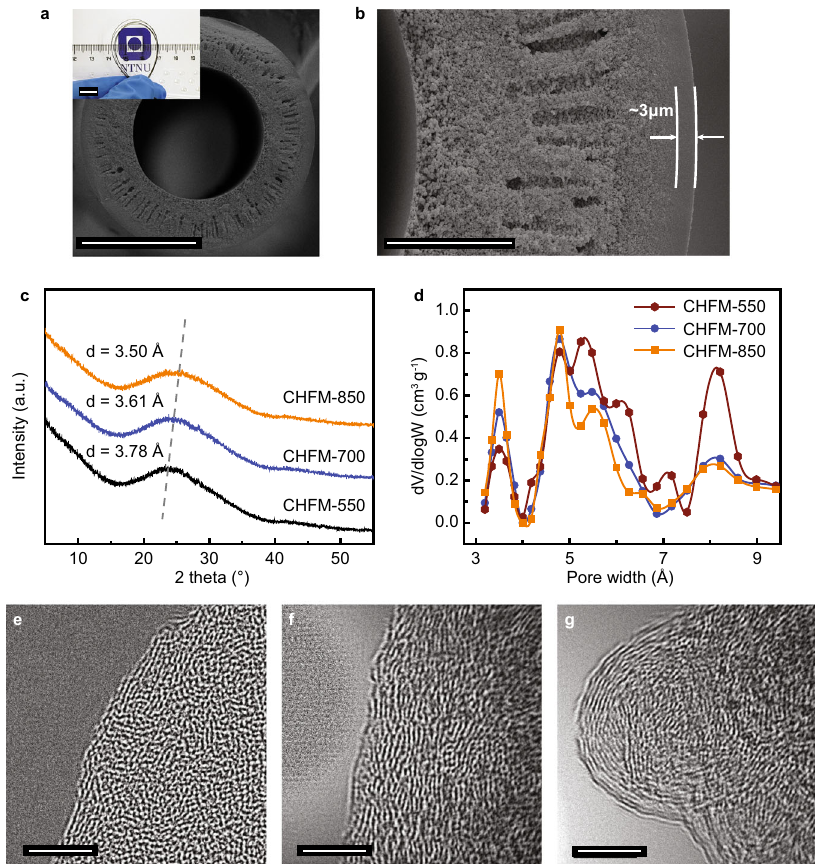
Fig. 2 Morphology and structure characterization of the carbon hollow fi ber membranes (CHFMs). a , b Cross-sectional SEM images of CHFM-700 (carbonized at 700 °C) (scale bars: a 100 μ m, b 20 μ m), and the inset shows a CHFM with a bend radius of <1.5 cm (scale bar: 1 cm), indicating mechanical fl exibility. The thickness of a selective layer is ca. 3 μ m, and the porous morphology is well-maintained after carbonization; c the XRD patterns of CHFMs carbonized at different temperatures. The d -space was calculated from the Bragg equation, and found to decrease from 3.78 to 3.5 Å with the increase of fi nal carbonization temperature from 550 to 850 °C, and d the pore size distributions of CHFMs calculated by the NLDFT model from CO 0 °C. The speci fi c volumes of ultramicropores (especially the pores of <4 Å) for CHFM-850 and CHFM-700 are larger compared to that of CHFM-550, indicating more diffusion (size)-selective membranes; e – g HR-TEM images of CHFM-550, CHFM-700, and CHFM-850, respectively. Scale bar: 5